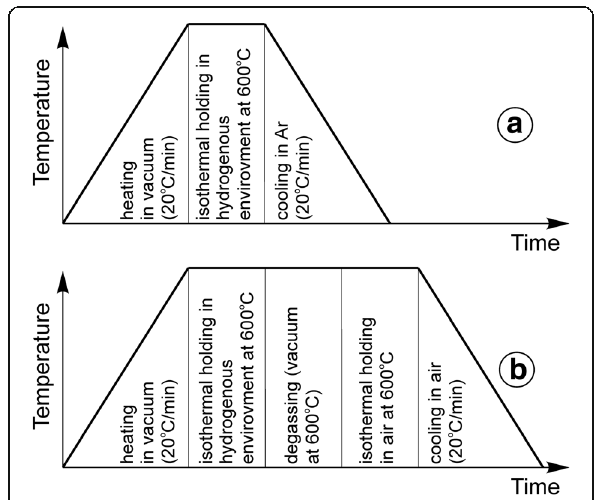
Fig. 1 The preconditioning schemes. a One-time reduction in a hydrogenous environment. b A cycle of redox